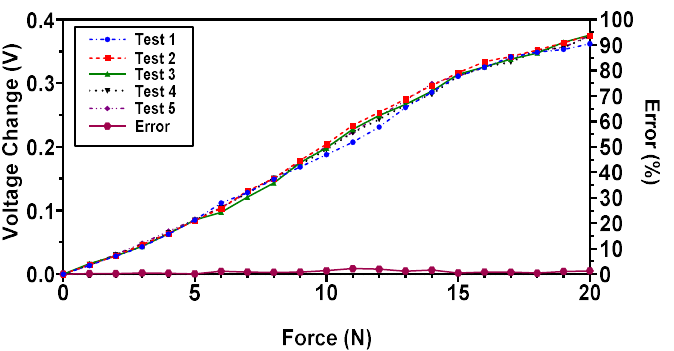
Figure 19. The voltage response of the proposed magnetic tactile sensor towards a force in the normal direction for five loading test cycles.